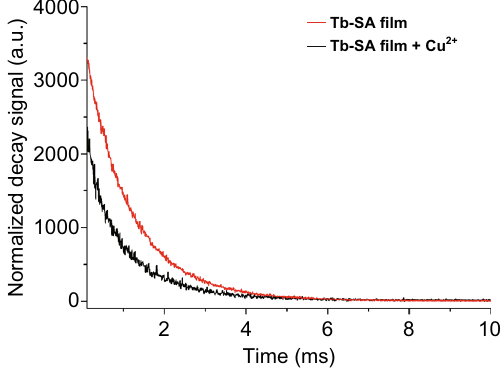
Fig. 17 The Stern–Völmer plots for PL quenching of Cu ‐ MOF ‐ NPs by T3 hormone at different five temperatures. Reproduced with per- mission from Ref. [50]. Copyright 2019, John Wiley &